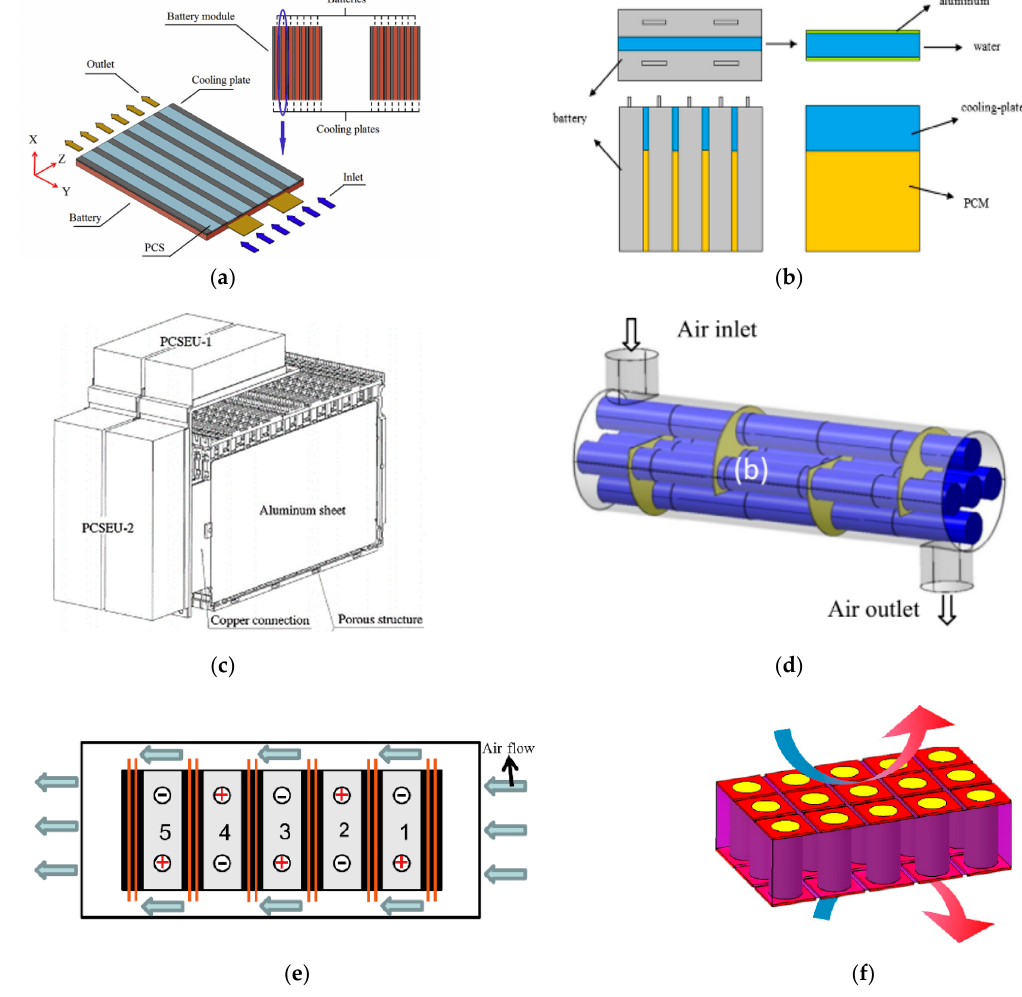
Figure 6. Classic structures of hybrid BTMS combining PCM with air or liquid active cooling